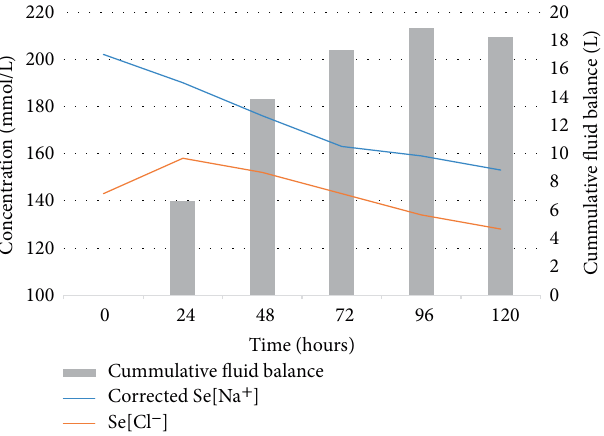
Figure 1: Serum sodium and fluid balance during